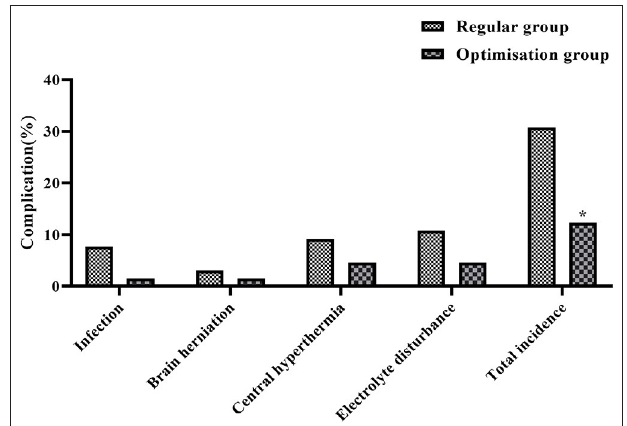
FIGURE 5 | Histogram comparing the incidence of complications between the two groups. *Denotes comparison with regular group, P <